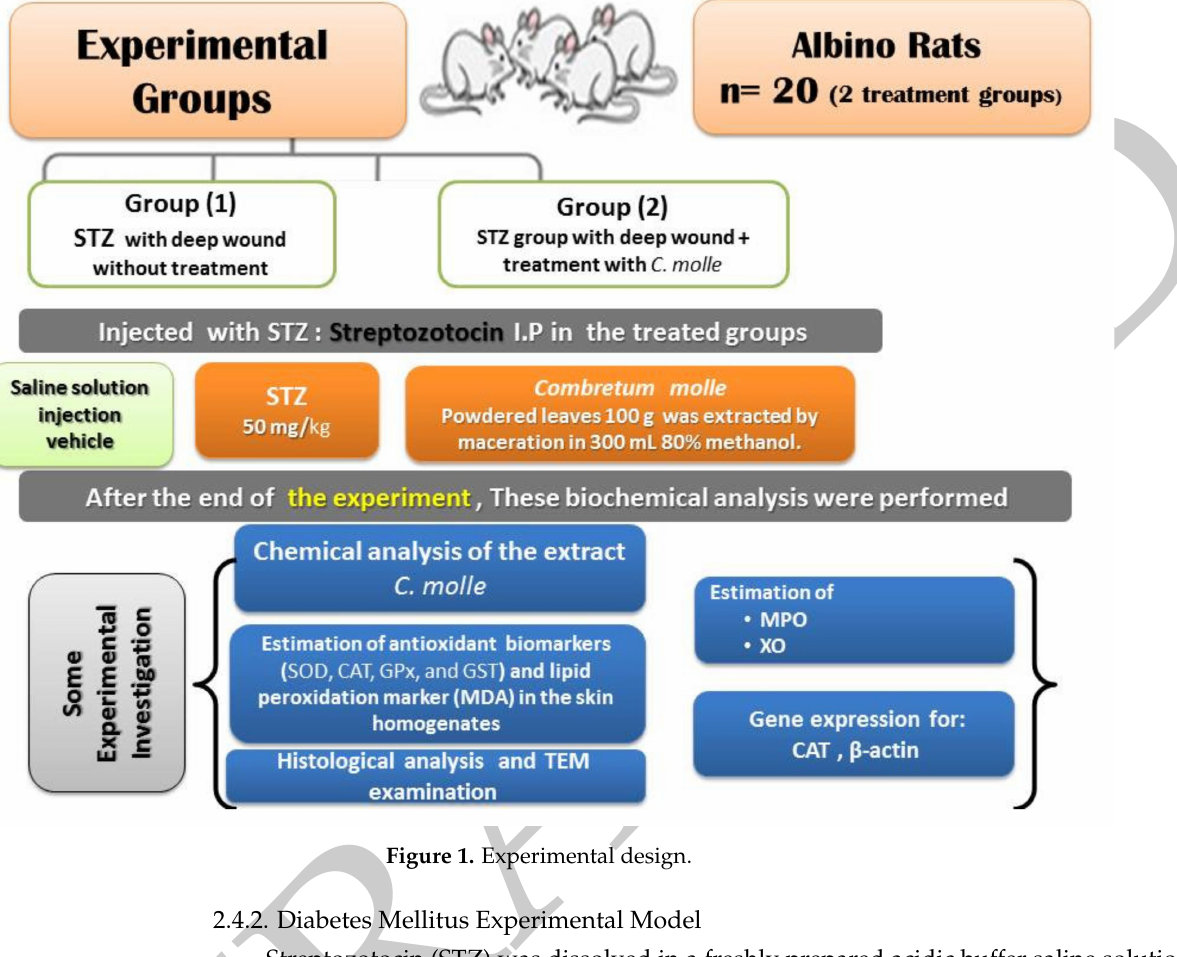
Figure 1. Experimental